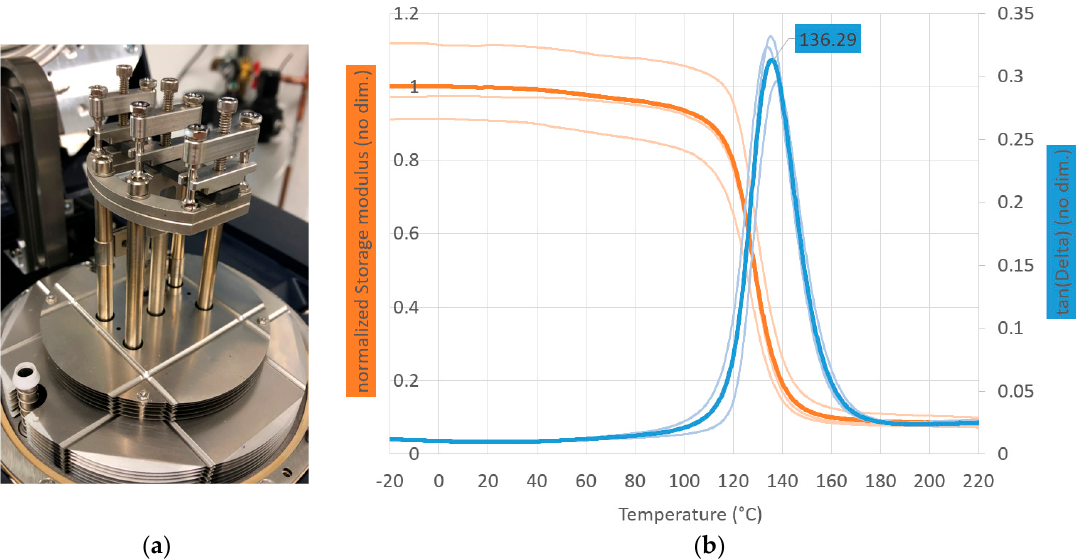
Figure 2. Dynamic mechanical analysis (DMA) in a DMA 850 (TA Instruments Inc., New Castle, PA, USA) of SMC material Polynt SMCarbon 80 CF60-3K/2: ( a ) Dual-cantilever measuring setup for